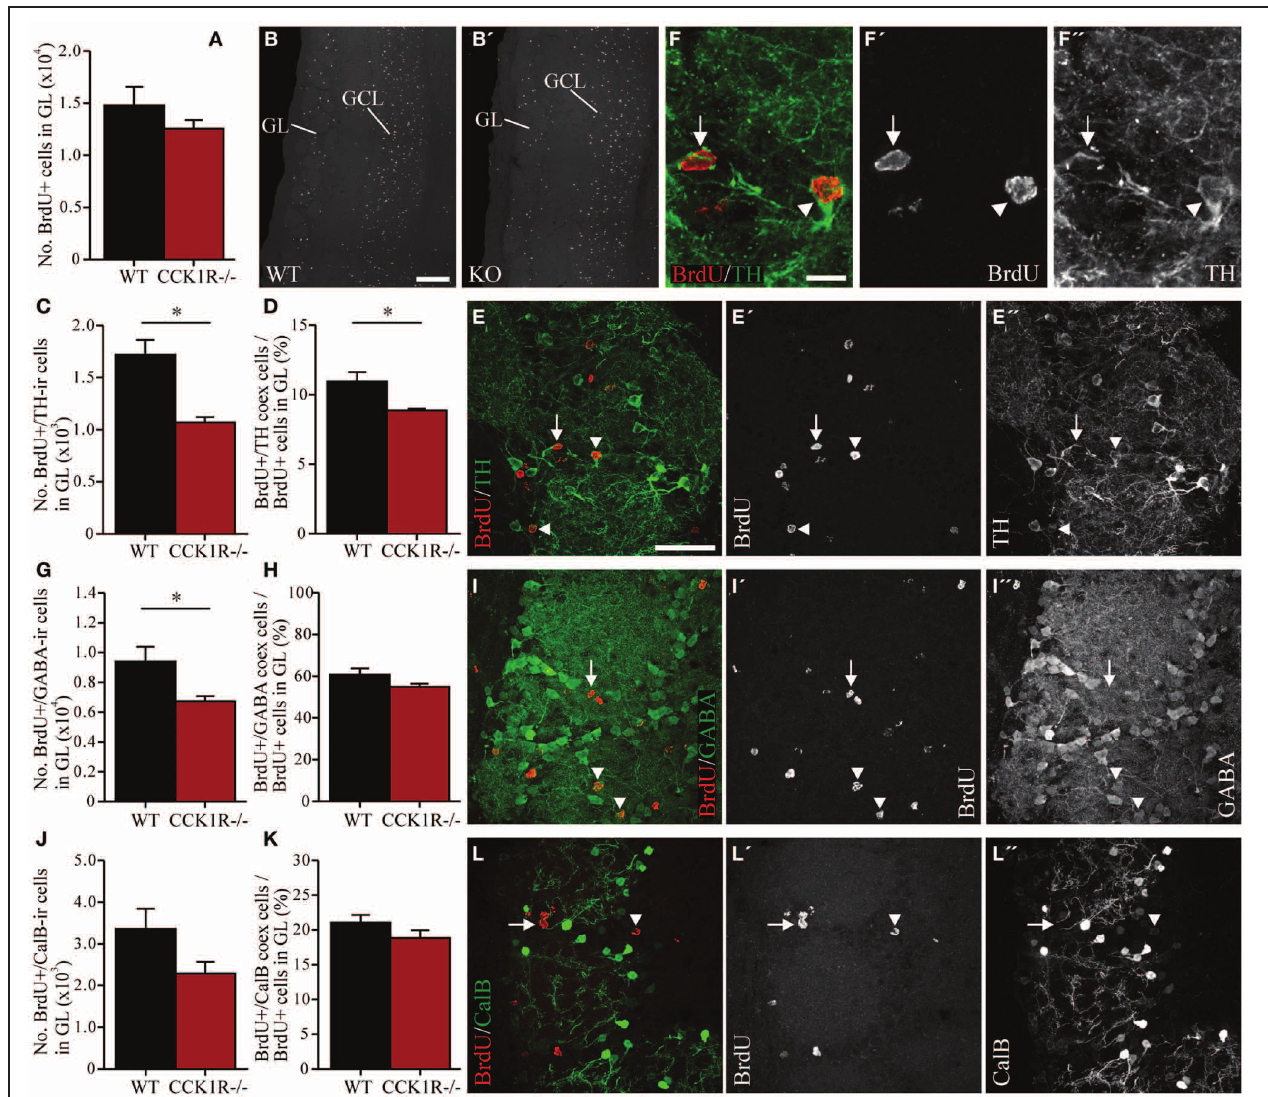
FIGURE 5 | Estimates of adult-born cells in the GL of female CCK1R − / − and wild-type mice. BrdU (50mg/kg i.p.) was administered twice daily for 5 consecutive days, and mice killed 42 days after the last BrdU administration (see Protocol 2 , Figure 1B ). (A,B) Estimated number of BrdU + cell bodies in the GL of wild-type and CCK1R − / − mice (A) . Photomicrographs of BrdU + cell bodies in the GL of (B) wild-type and (B (cid:3) ) CCK1R − / − mice. (C–F) Estimated number of BrdU + and TH-ir double-labeled cell bodies in the GL of wild-type and CCK1R − / − mice (C) . (D) Estimated number of BrdU + /TH-ir co-expressing cell bodies expressed as a proportion of the total number of BrdU + cell bodies in the GL of wild-type and CCK1R − / − mice. (E) Double-immunofluorescence confocal micrograph of BrdU-LI ( E (cid:3) , red) and TH-LI ( E (cid:3)(cid:3) , green) in the GL of CCK1R − / − mouse, shown at higher magnification in (F) , (F (cid:3) ) , and (F (cid:3)(cid:3) ) , respectively. (G–I) Estimated number of BrdU + and GABA-ir double-labeled cell bodies in the GL of wild-type and CCK1R − / − mice (G) . (H) Estimated number of BrdU + /GABA-ir co-expressing cell bodies expressed as a proportion of the total number of BrdU + cell bodies in the GL of wild-type and